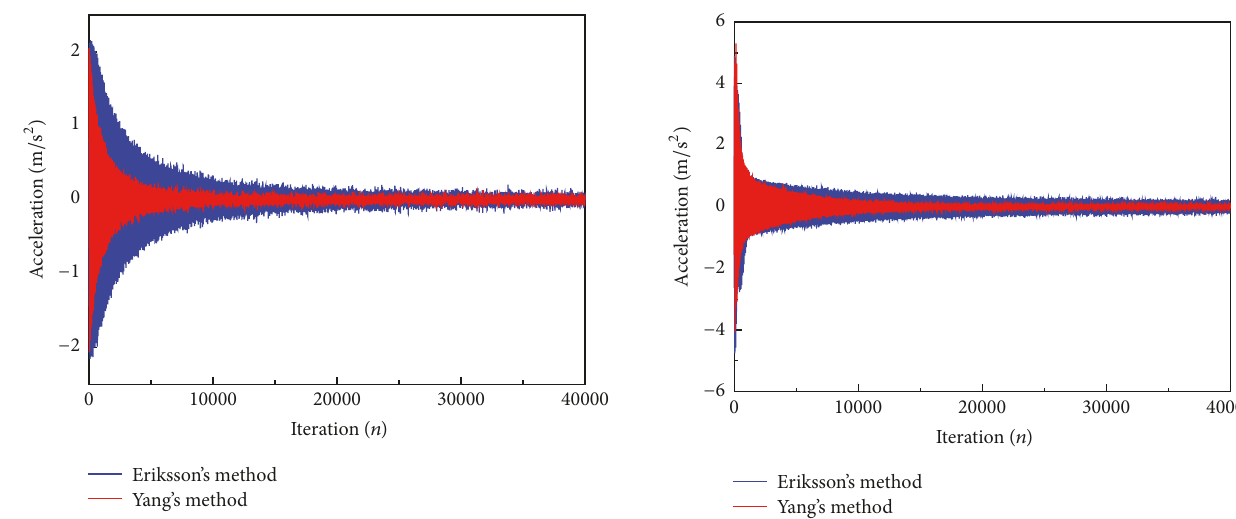
Figure 8: Acceleration of the controlled point of existing